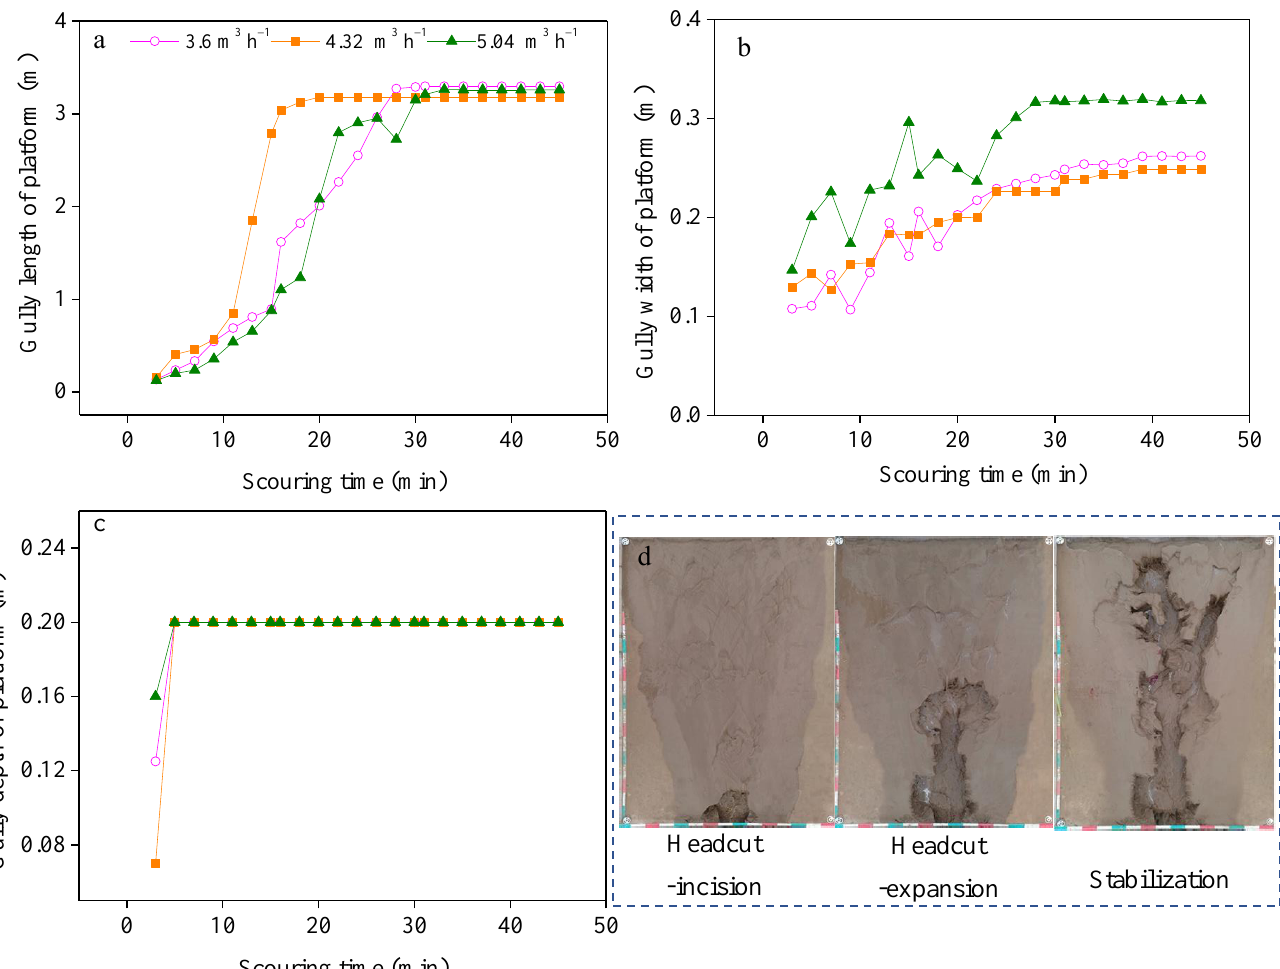
Figure 3. ( a ) Variation in gully length; ( b ) Variation in gully depth; ( c ) Variation in gully width; ( d ) Images of gully morphology on the platform in the stages of headcut-incision, headcut- expansion and stabilization, respectively.